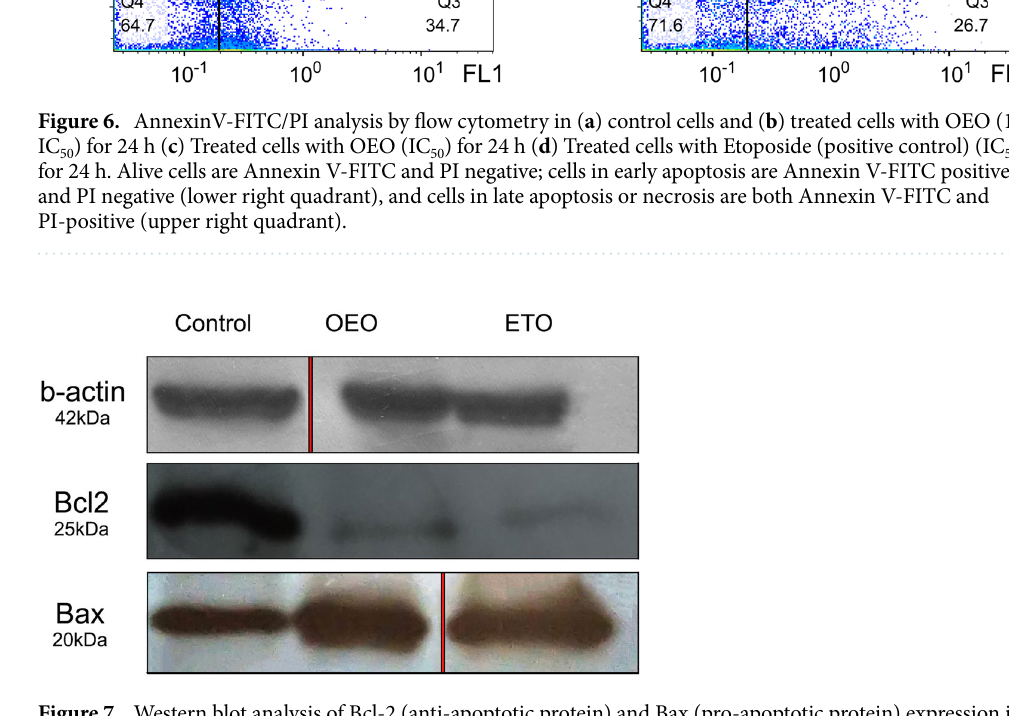
Figure 7. Western blot analysis of Bcl-2 (anti-apoptotic protein) and Bax (pro-apoptotic protein) expression in control cells and treated cells with OEO (IC 50 ) and Etoposide (positive control) (IC 50 ) for 24 h. The raw figures of blots has been provided in the “Supplementary